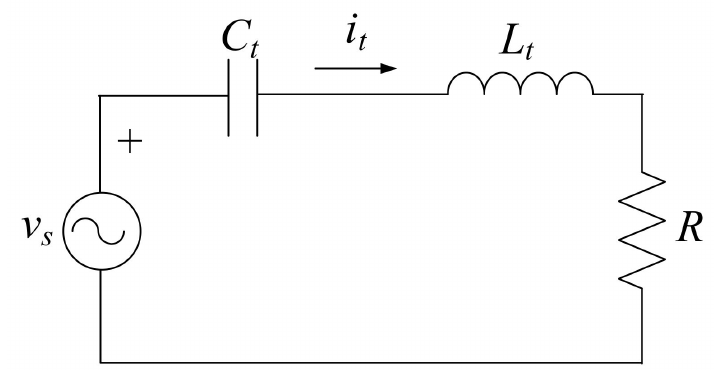
Figure 3. Equivalent circuit of the transmission side of WPT system shown in Figure